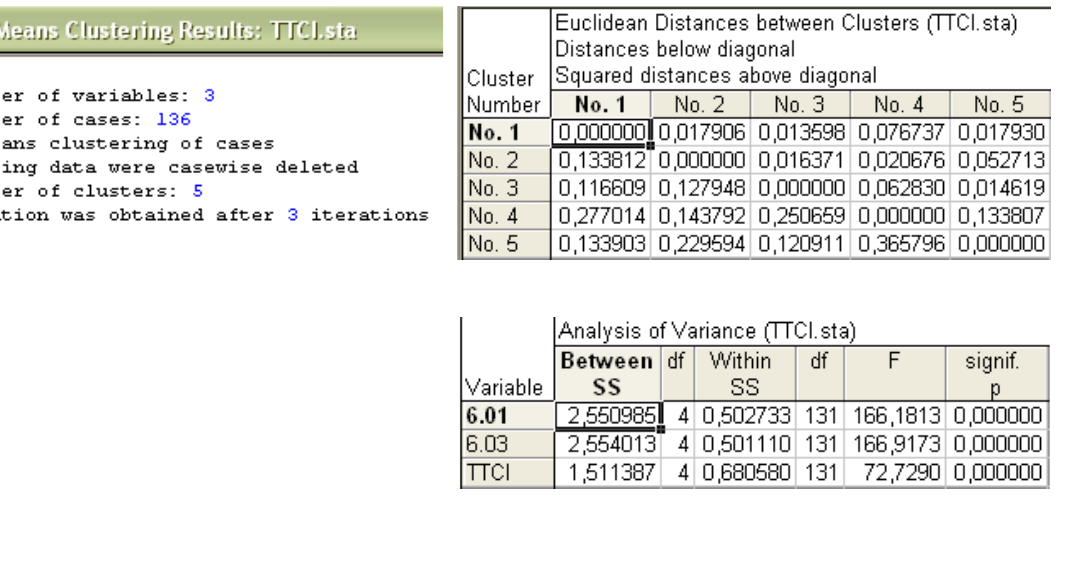
Figure A1. The analysis of variance and model